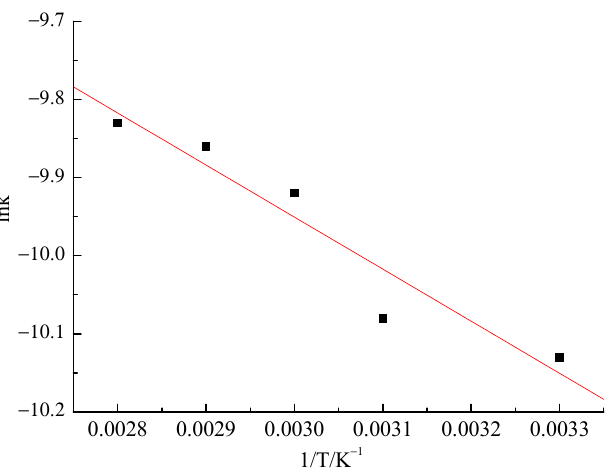
Figure 12. Relation of ln k and 1/ T (R 2 = 0.9159) for leaching times greater than 120 min.